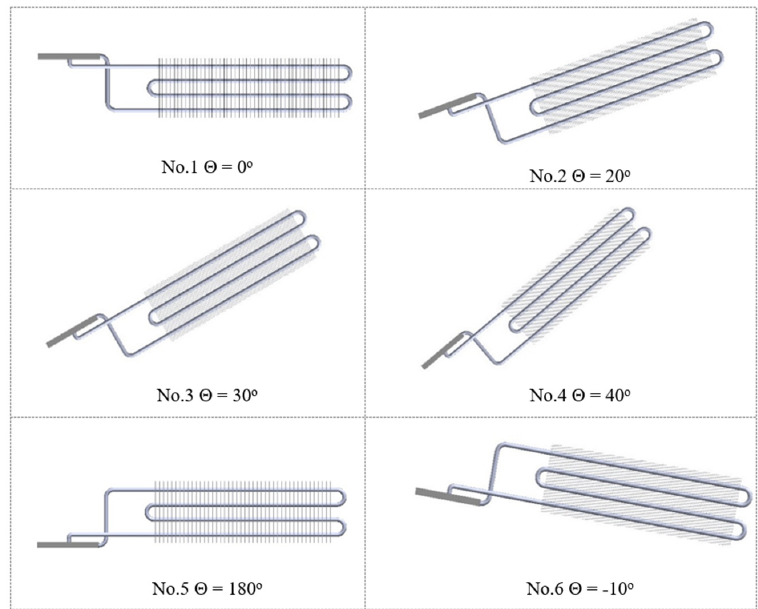
Figure 7. Diagram of the LHP under different positions.